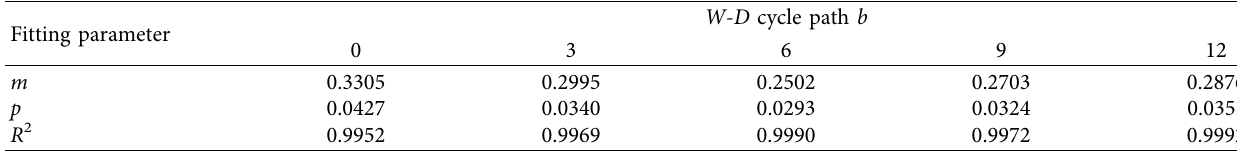
Table 10: Fitting parameters of λ and ε